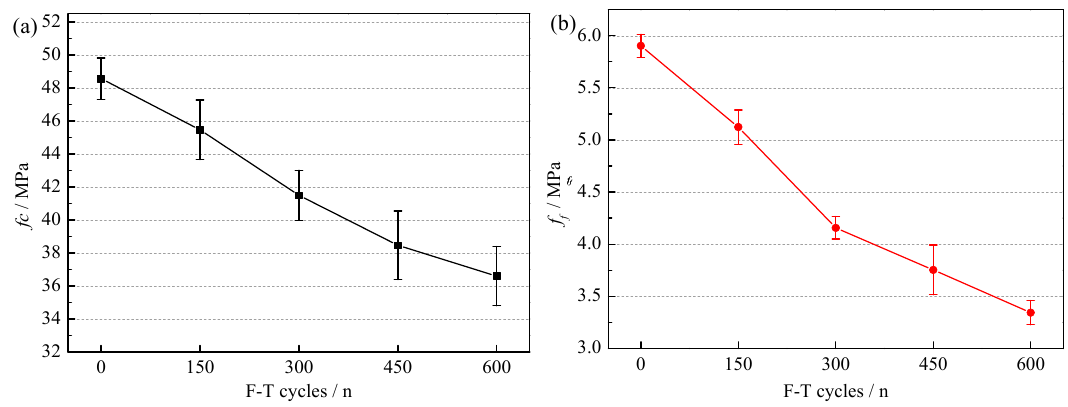
Figure 4. The variations of f c ( a ) and f f ( b ) of NAC after F-T